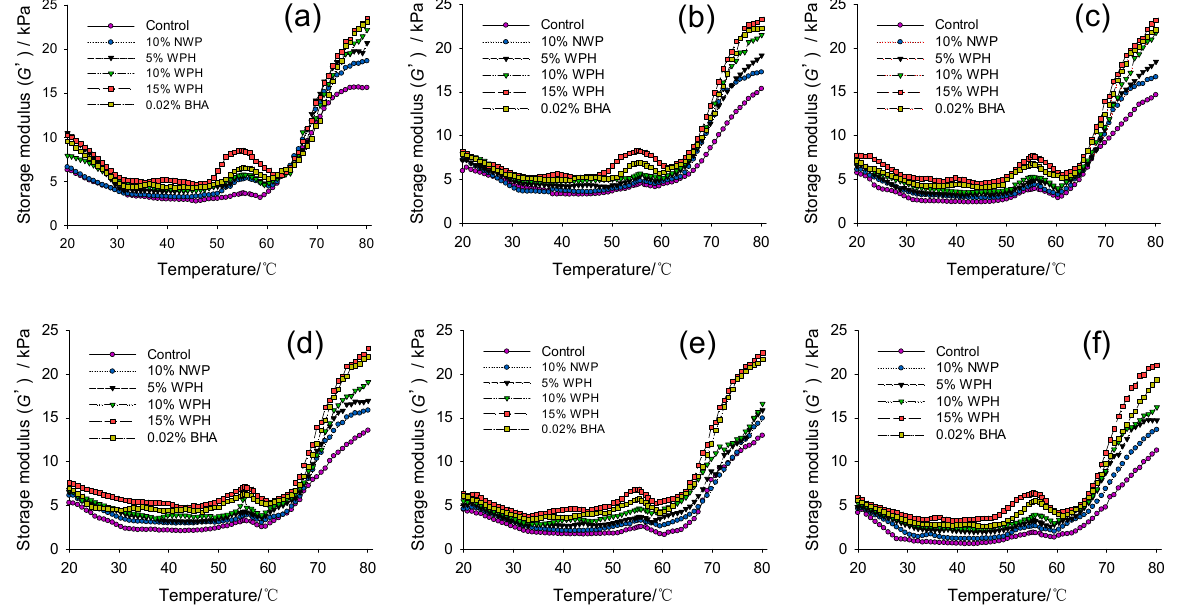
Figure 6. Changes in dynamic storage modulus (G ′ ) of multiple freeze–thaw (F–T) cycles of pork patties with different whey protein hydrolysate (WPH) contents. ( a – f ): 0, 1, 3, 5, 7, 9 freeze–thaw cycles. Control: without any additives in the sample; NWP: native whey protein; BHA: butylated hydroxyanisole.